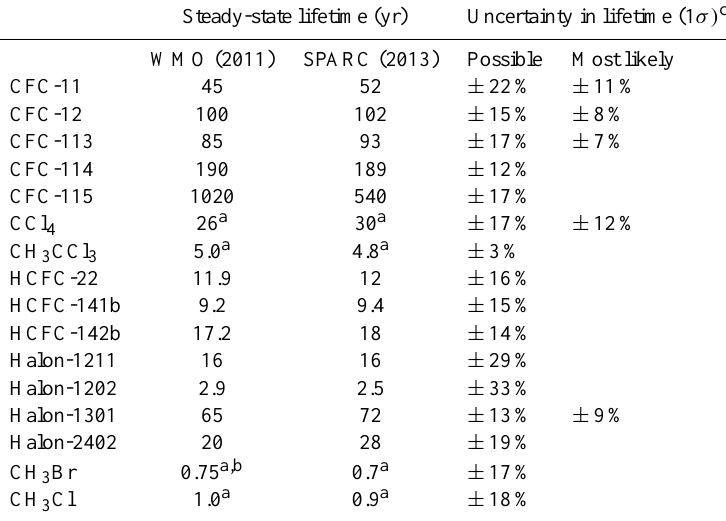
Table 1. Lifetimes and uncertainties of ODSs from WMO (2011) and SPARC (2013). Steady-state lifetime